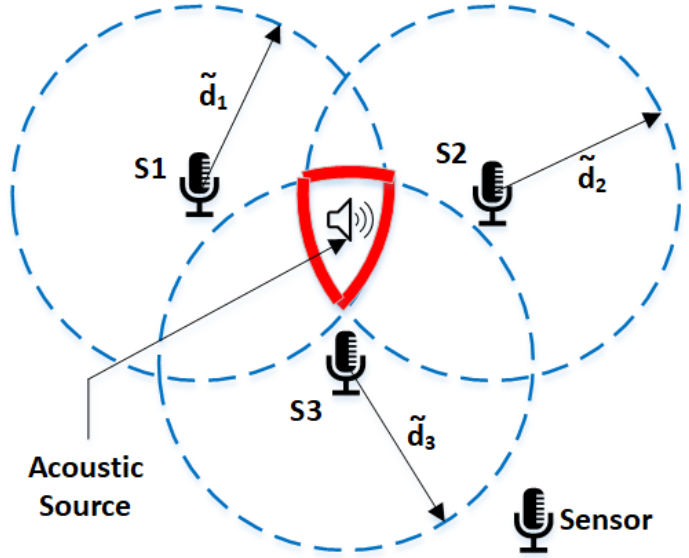
Figure 1. Sensors’ distance estimate representation when measurement noise is